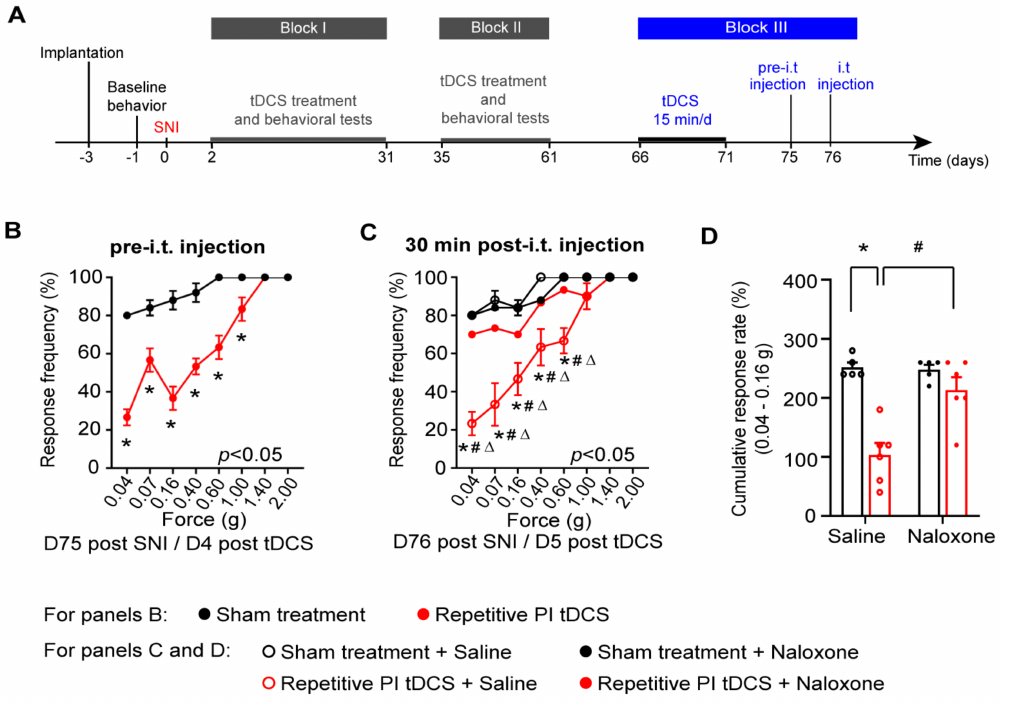
Figure 4. Anti-allodynic effect of repetitive PI tDCS requires spinal opioidergic signaling. ( A ) Schematic overview of testing the effect of intrathecal (i.t.) injection of the opioid-antagonist naloxone or saline (control) on suppression of mechanical allodynia over chronic stages of neuropathic pain. ( B ) Comparison of neuropathic mechanical allodynia between the groups of sham treatment and PI tDCS 5 days after the last session of the treatment prior to i.t. injection of naloxone or saline. ( C , D ) In the same mice, analysis of neuropathic mechanical allodynia after i.t. injection of naloxone or saline, showing naloxone-induced reversal of the antiallodynic effect of PI tDCS. Panel ( C ) shows the stimulus response curve to graded von Frey filaments and panel ( D ) shows cumulative responses to filaments exerting low forces that are non-noxious in control conditions and elicit allodynia in neuropathic conditions; n = 5 for the sham treatment group and n = 6 for the repetitive PI tDCS group; repeated measures ANOVA with Sidak’s multiple comparisons test was performed; * p < 0.05 as compared to the sham treatment group. # p < 0.05, ∆ p < 0.05 as compared to the